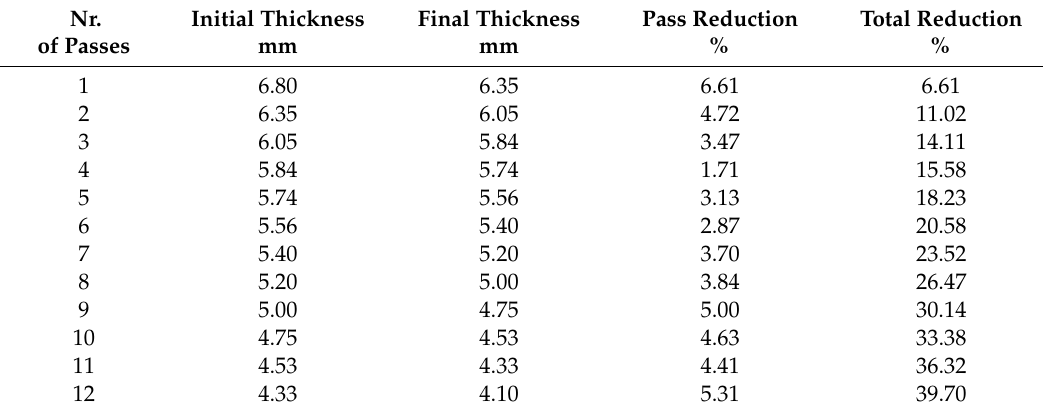
Table 3. Cold rolling deformation parameters for Cu-5%Fe 3 O 4 nanocomposite. Nr.